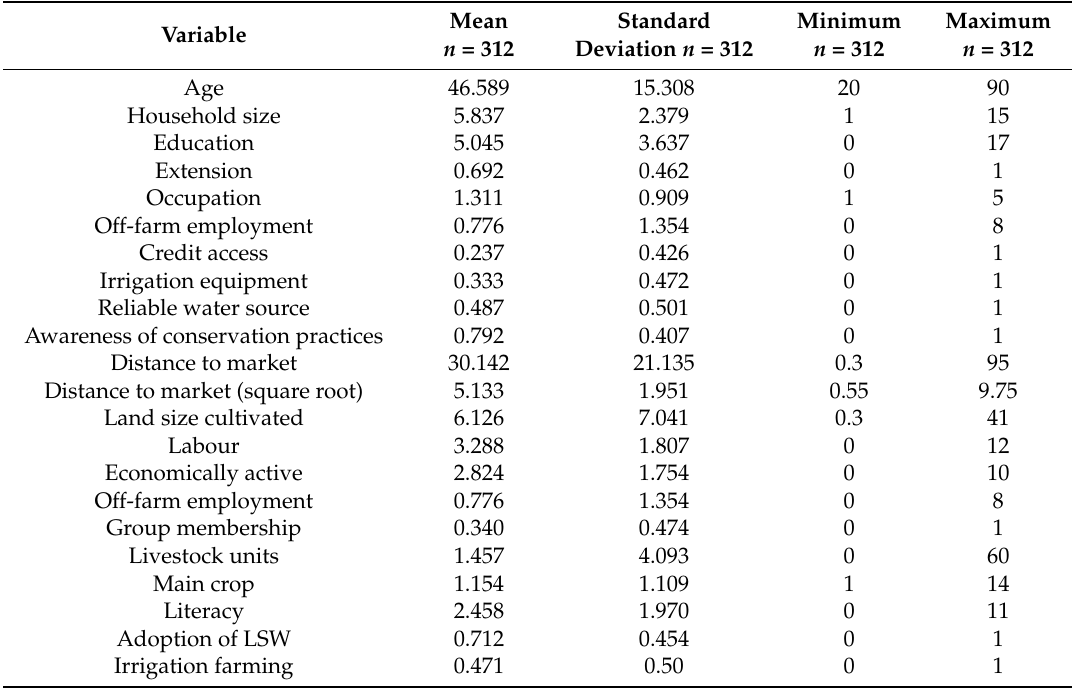
Table 4. Statistics of variables used in the econometric